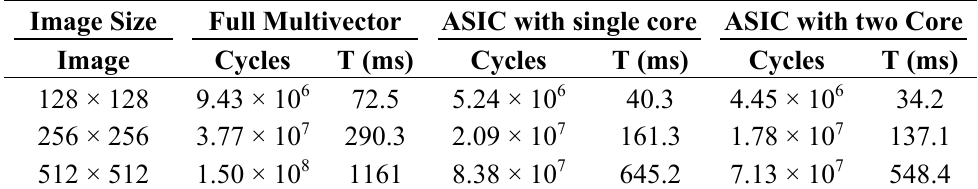
Table 10. Eight geometric additions for rotor